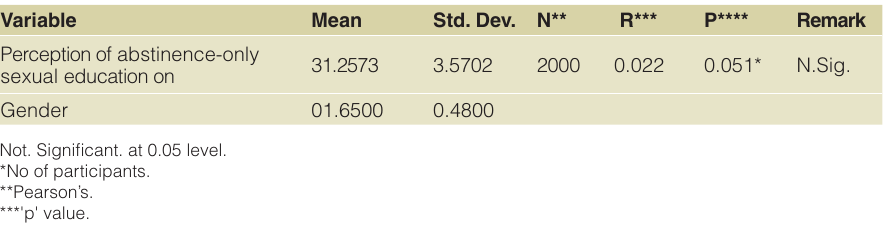
Table 11. Relationship between gender and perspective on abstinence-only sexual